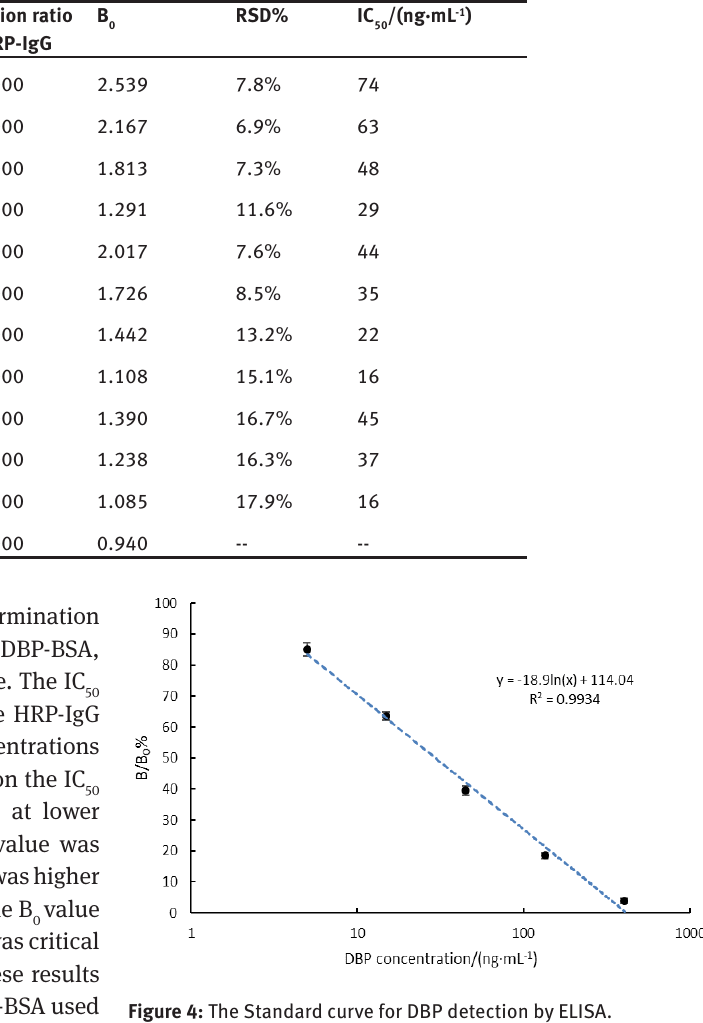
Figure 4: The Standard curve for DBP detection by